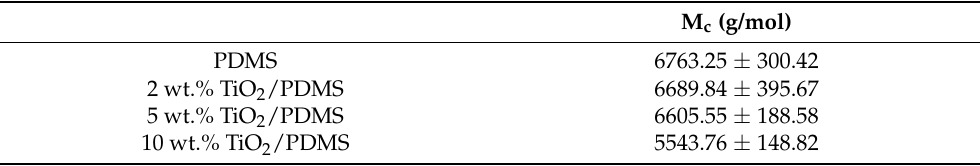
Table 4. M c (g/mol) results of TiO 2 /PDMS nanocomposites based on swelling (Flory-Rehner